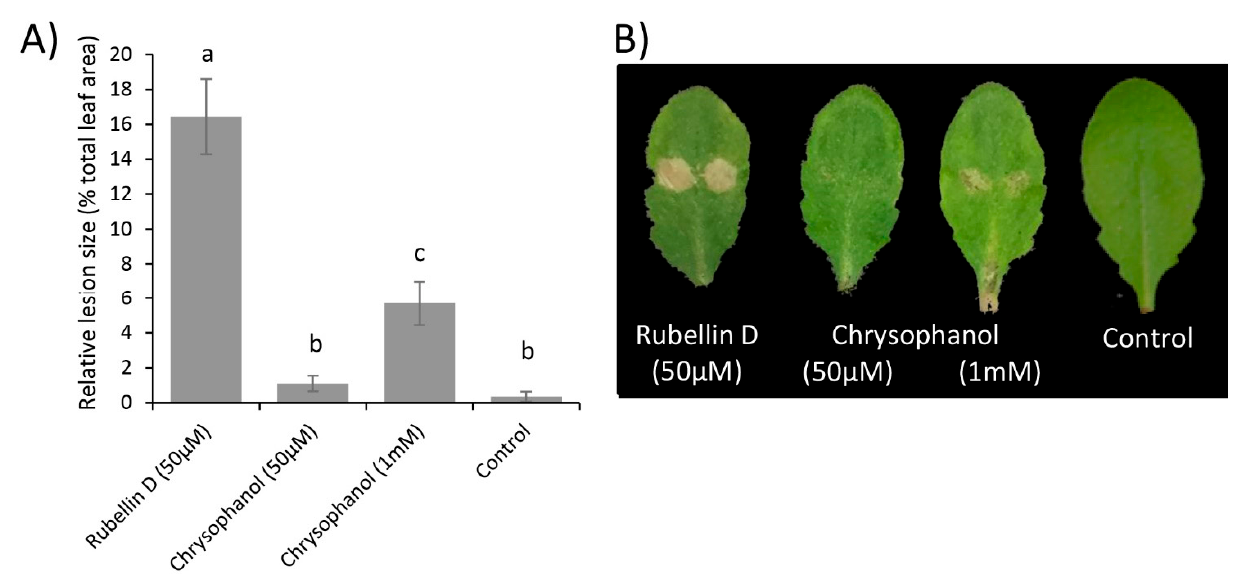
Figure 5. Lesions induced by rubellin D 4 and chrysophanol 7 following infiltration in leaves of A. thaliana . ( A ) Relative lesion size in leaves infiltrated with rubellin D 4 , chrysophanol 7, or MgCl 2 (control) measured after 24 h. Data show the average mean relative lesion size ± standard error of three independent experiments of at least 10 leaves each. Significant differences are shown by different letters. ( B ) Representative pictures of lesions observed after 24 h following infiltrations.